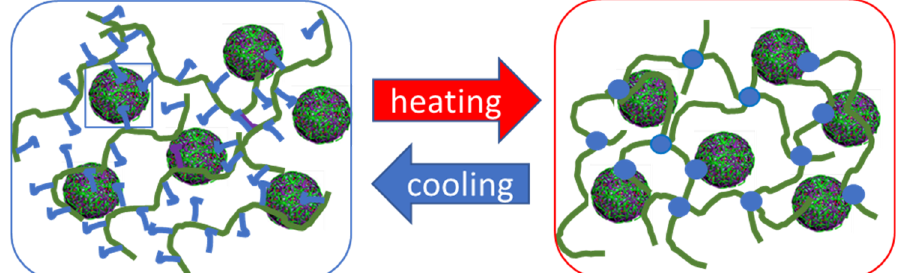
Scheme 3. Schematic representation of the thermo-responsive behavior of the hNP/hydrogel composite. Upon heating a network form, constituted of Alginate chains (green lines), crosslinked by hydrophobic association of the side chains (blue spheres), the hNPs contribute to crosslinking. The process is reversible. For clarity, the negative charges of Alginate have been omitted.